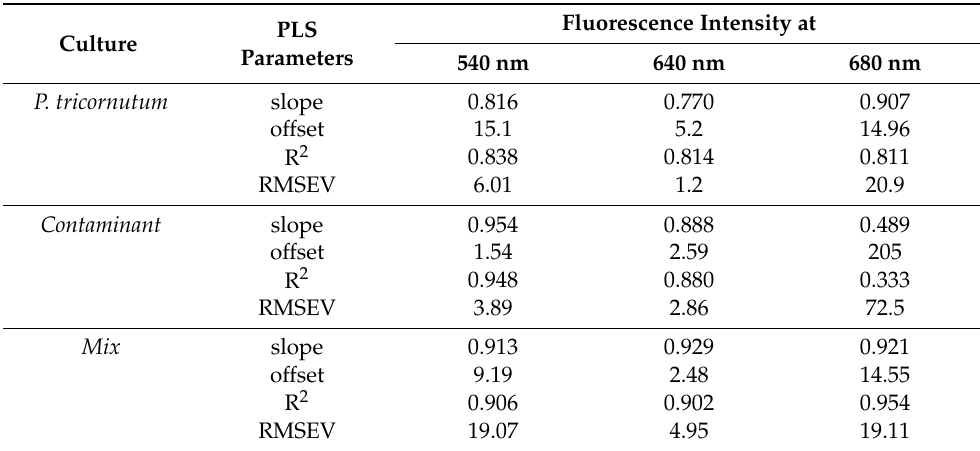
Table 1. PLS regression parameters between E-tongue response and fluorescence intensities of tested microalgae cultures at 540, 640 and 680 nm respectively. Fluorescence Intensity at PLS Culture Parameters 540